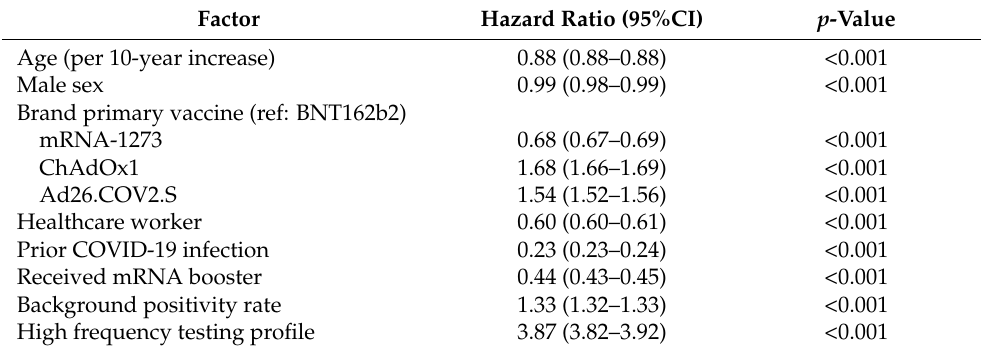
Table 2. Factors associated with breakthrough infection (multivariable Cox proportional hazards regression).